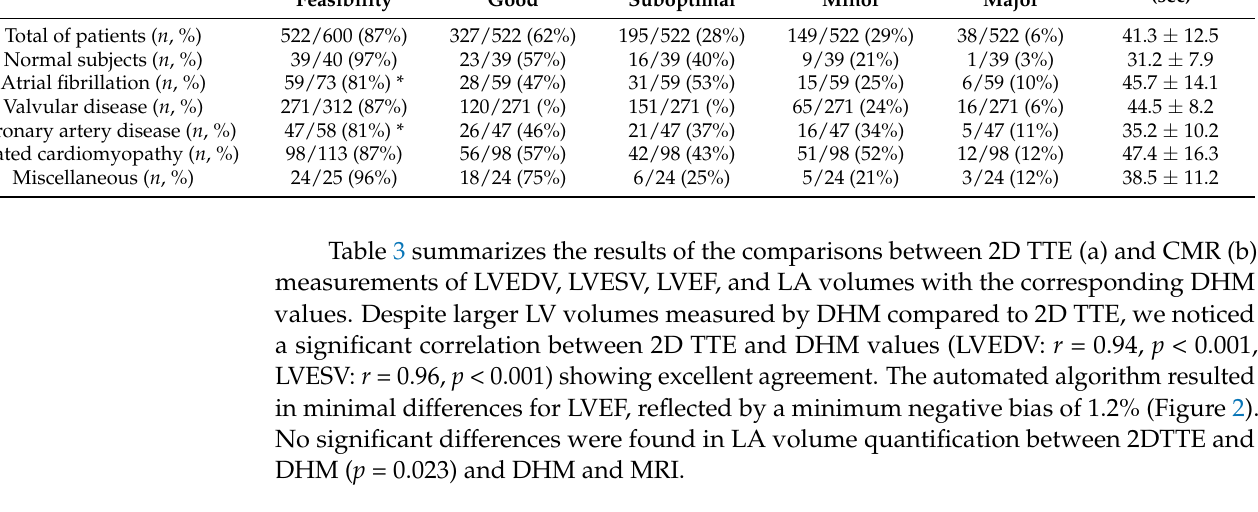
Table 3. Mean values of left chamber volumes and ejection fraction measured using automated software, conventional volu- metric approach, and cardiac magnetic resonance. Correlations between DHM with the other techniques. TTE = transthoracic echocardiography; DHM = dynamic heart model; CMR = cardiac magnetic resonance; LOA = limits of agreement.